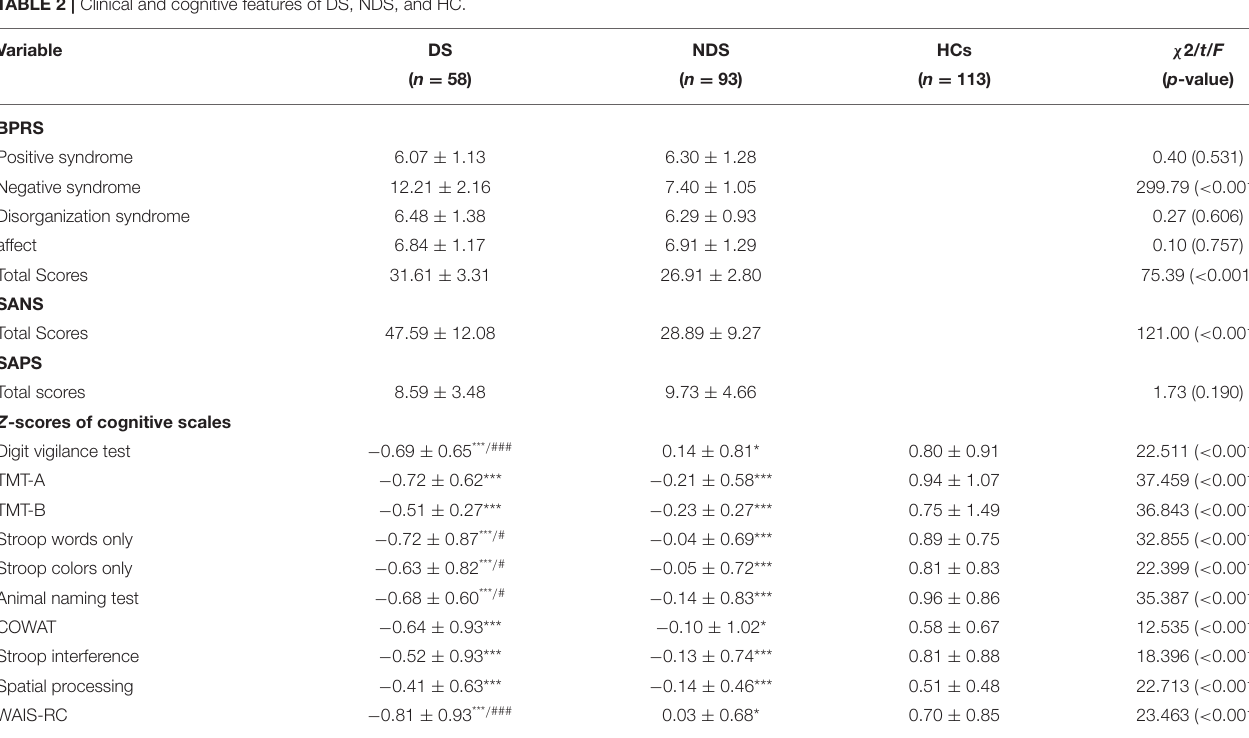
TABLE 2 | Clinical and cognitive features of DS, NDS, and